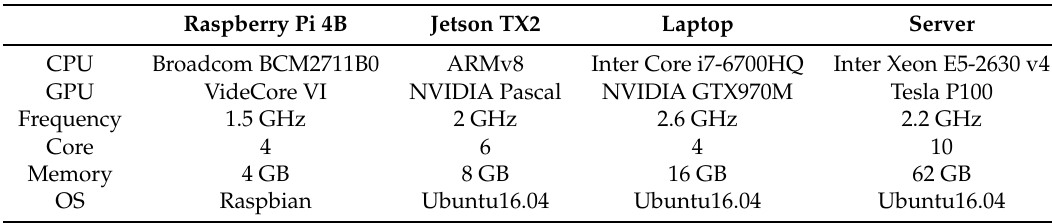
Table 1. Hardware setup and